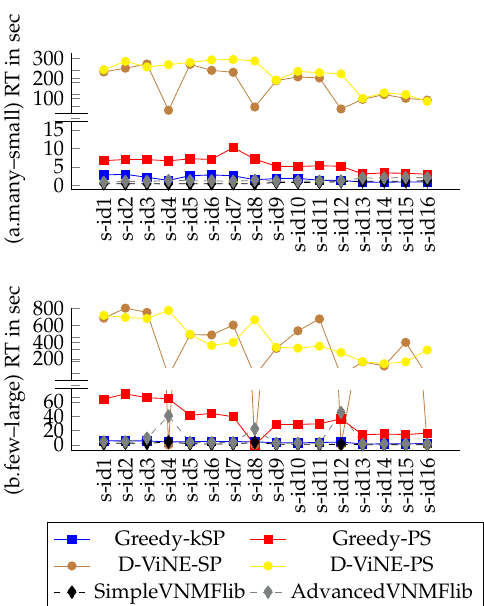
Figure 4. Execution times of the examined embedding strategies. Cost/Revenue multiplied by Mapped Revenue (CR*MR)—The SimpleVNMFlib imple- mentation that incorporates a 10-hop static SLL value and invokes inflexibly and constantly longer network paths in comparison to the AdvancedVNMFlib alternative, which supports values from 1 to 10. Furthermore, while the two stages coordination and uncoordinated strategies appear to perform more efficiently over SimpleVNMFlib regarding the CR*MR index, AdvancedVNMFlib achieves embeddings that are noticeably of lower cost during both scenario orientations.